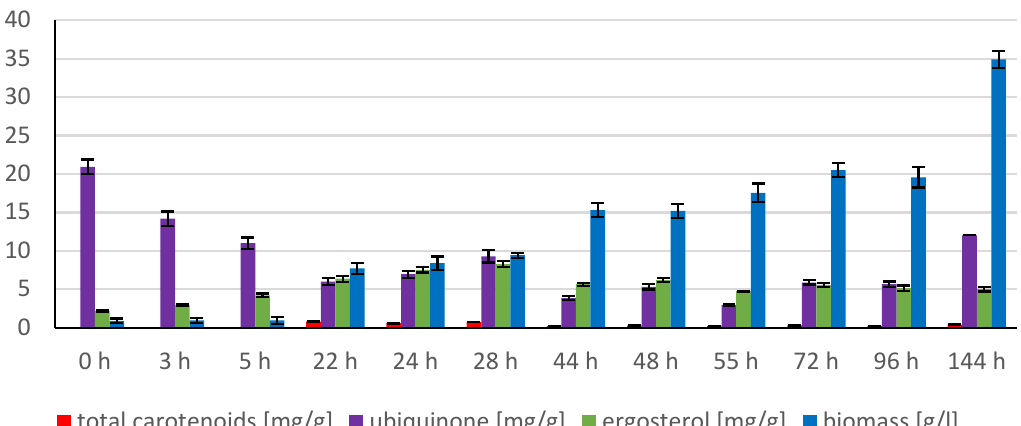
Figure 6. Fatty acid distribution in lipids of yeast strain Rhodotosporidium toruloides in conditions of C/N ratio 50.